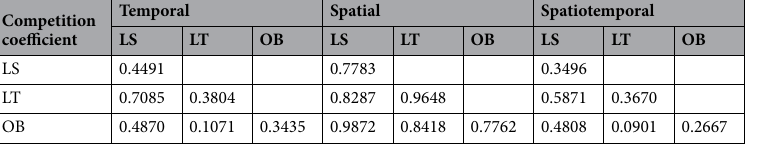
Table 4. Competition coefficients of the two leafminer species, Liriomyza sativae (LS) and L. trifolii (LT) and the pupal parasitoid, Opius biroi